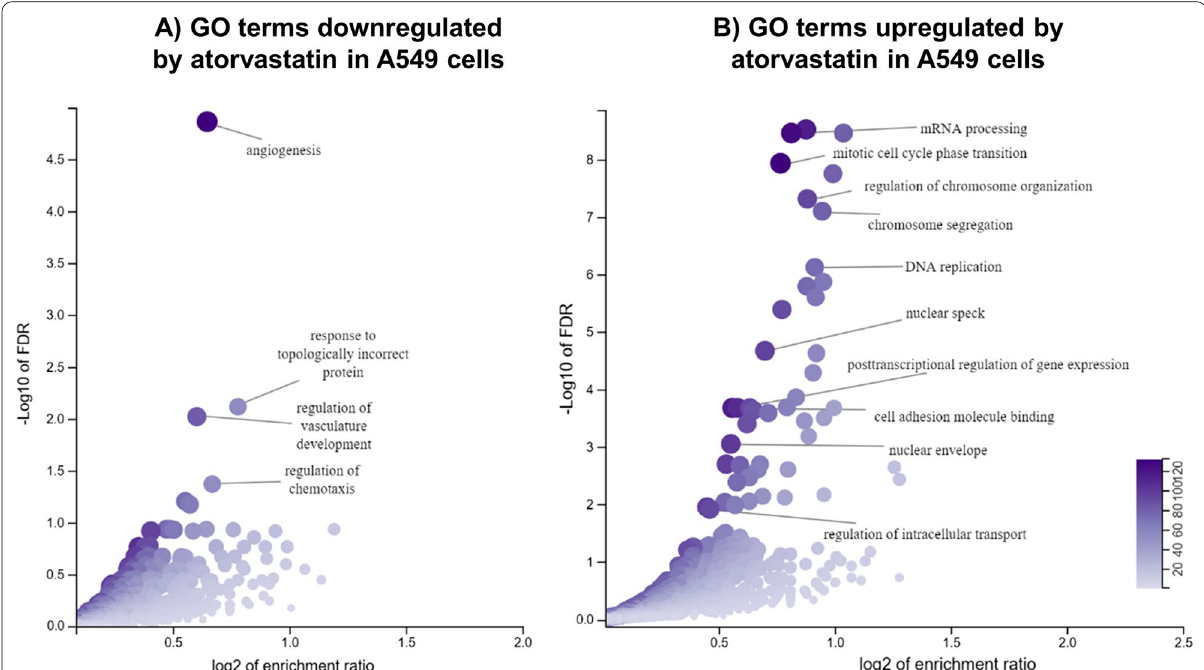
Fig. 4 Gene ontology analysis of the genes differentially regulated in A549 cells upon treatment with atorvastatin, based on transcriptomic data from the L1000 repository. Volcano plots show the GO terms enriched within the A downregulated and B upregulated genes after treatment with this drug. The Y axis shows significance in the log10 scale, and the X axis, the enrichment ratio for each GO term (represented as dots in the −